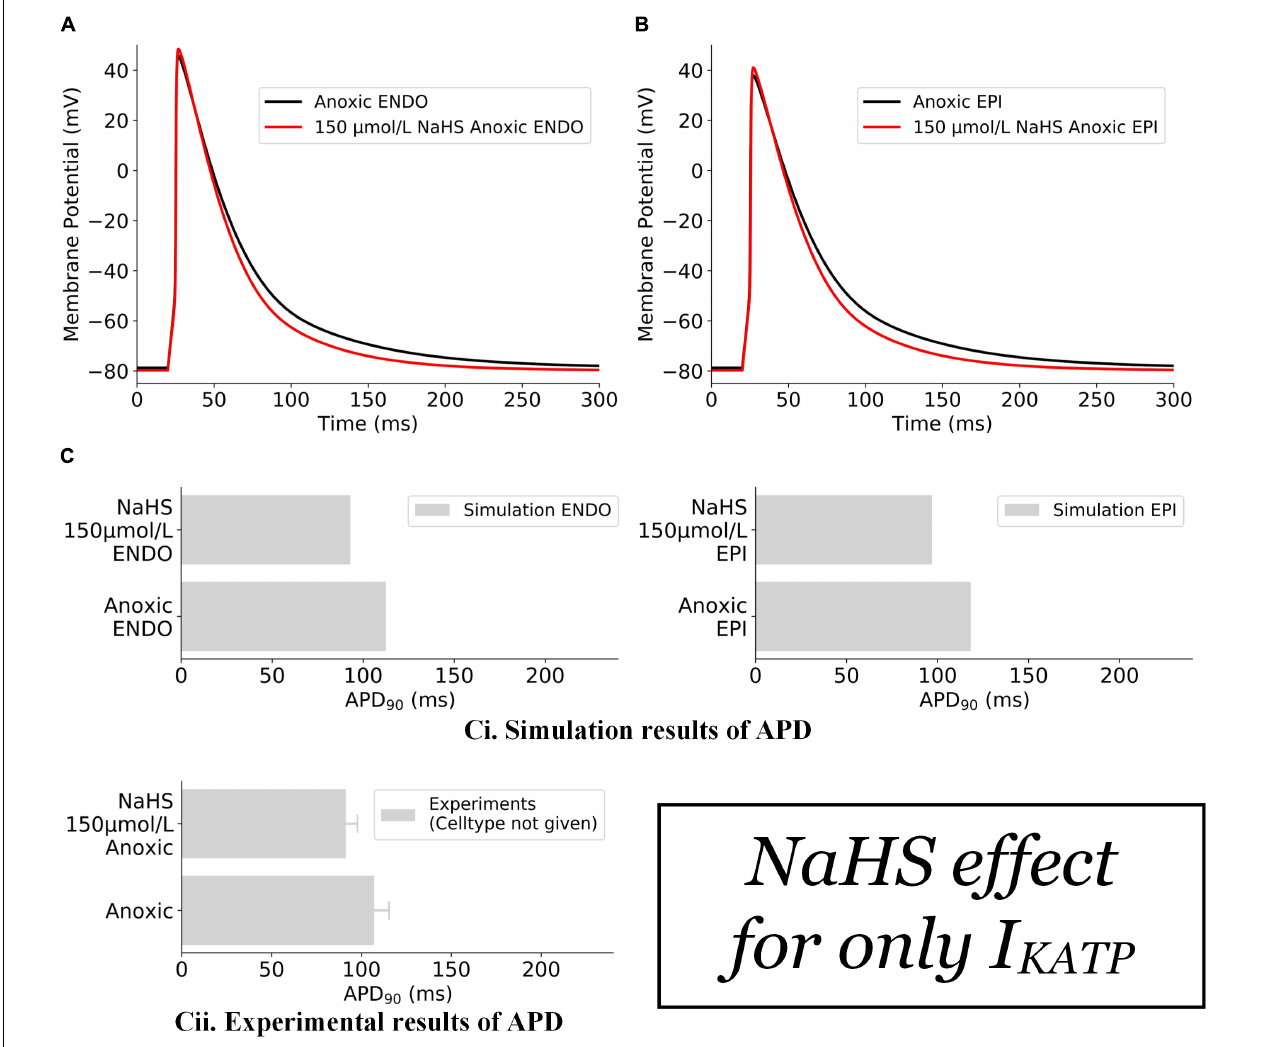
FIGURE 2 | Effects of 150 µ mol/L NaHS on AP of anoxic ventricular myocytes via I K , ATP alone. (A) APs of endocardial myocytes in control and NaHS condition. (B) APs of epicardial myocytes in control and NaHS conditions. (C) Comparison of simulated APD abbreviation with experimental data. (i) Simulation results; (ii) experimental results from Zhong et al. (2010) without specifying cell types. In the simulations, I to , I CaL , and I K 1 were blocked in accordance with experimental settings. AP, action potential; APD, action potential